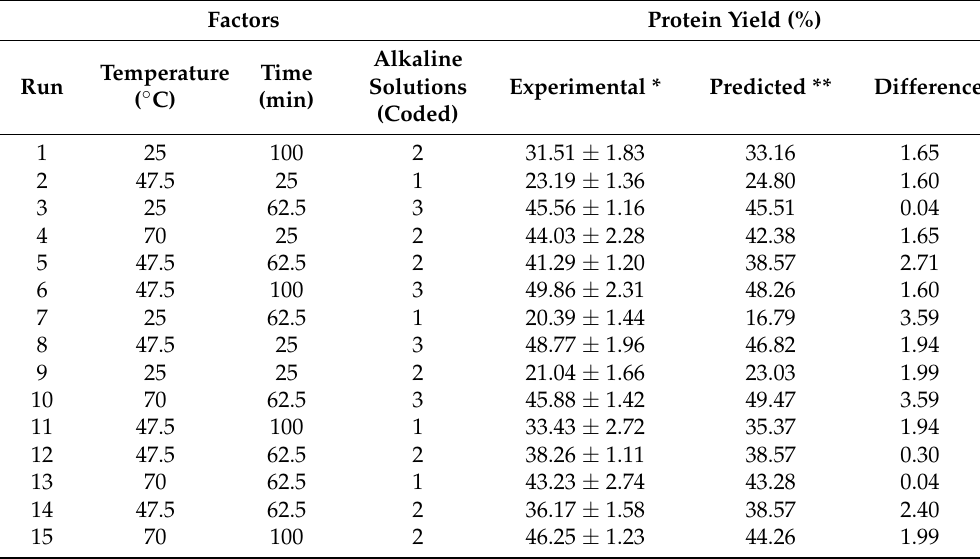
Table 4. Experimental and predicted values of the protein yield after the extraction process according to the Box–Behnken design.